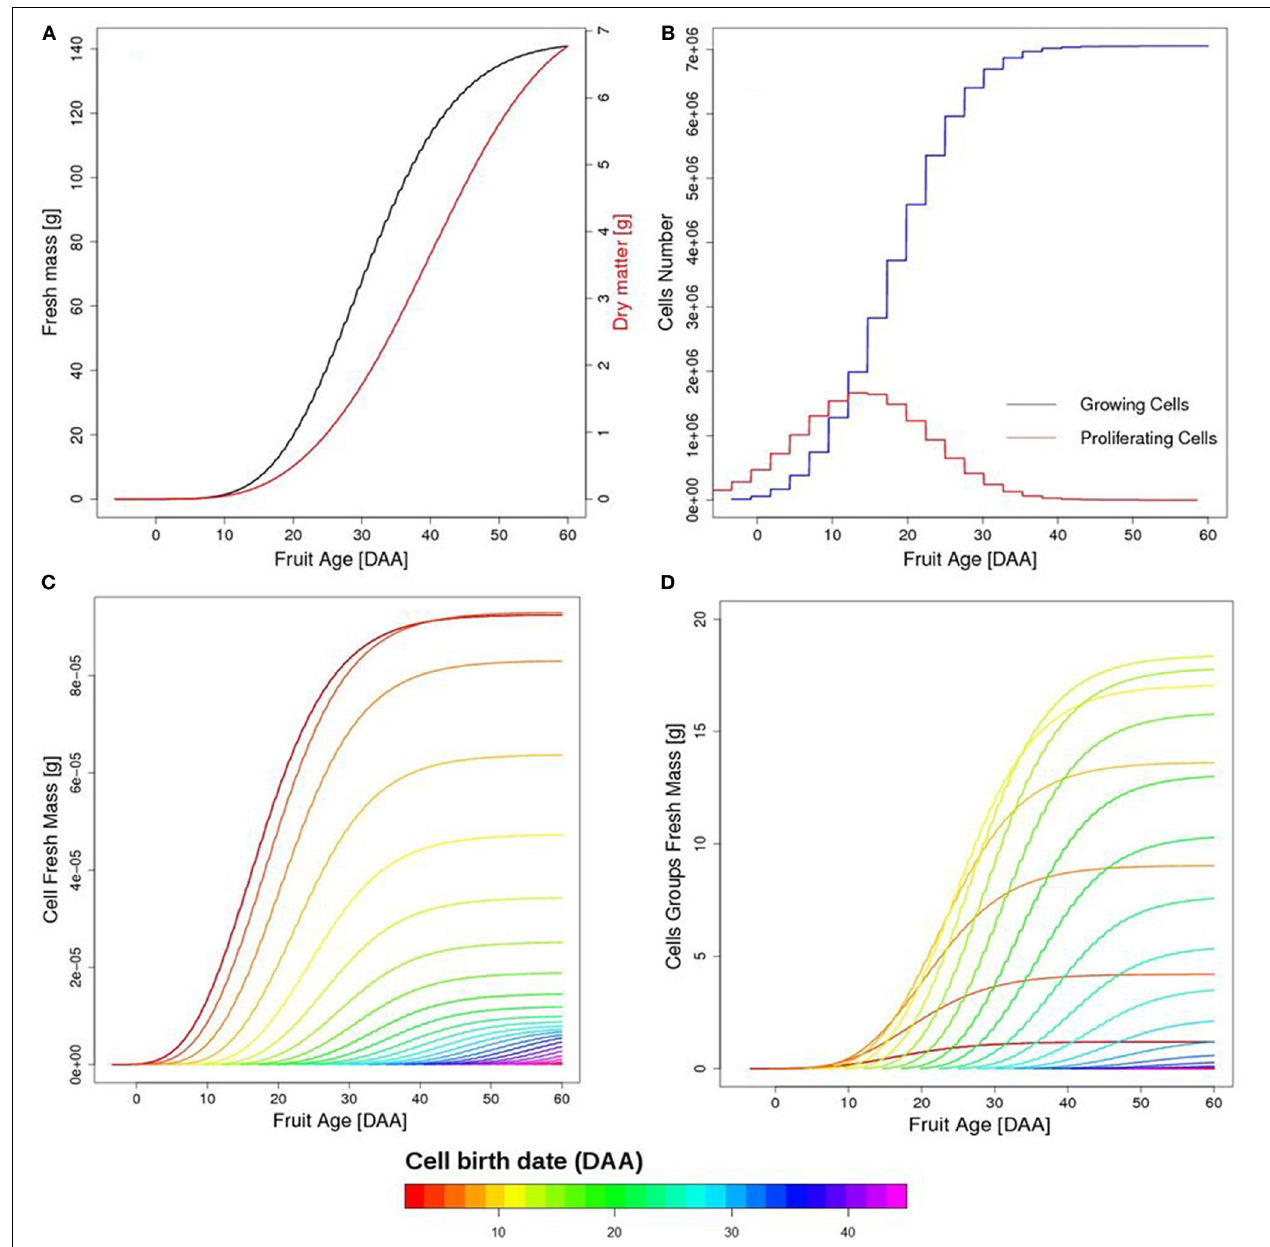
FIGURE 5 | Temporal evolution of simulated fruit fresh and dry mass (A), as a function of fruit age in days after anthesis (DAA). Temporal evolution of growing and proliferating cell populations (B) . Growth of individual cells as a function of fruit age (1 cell per group), with colors